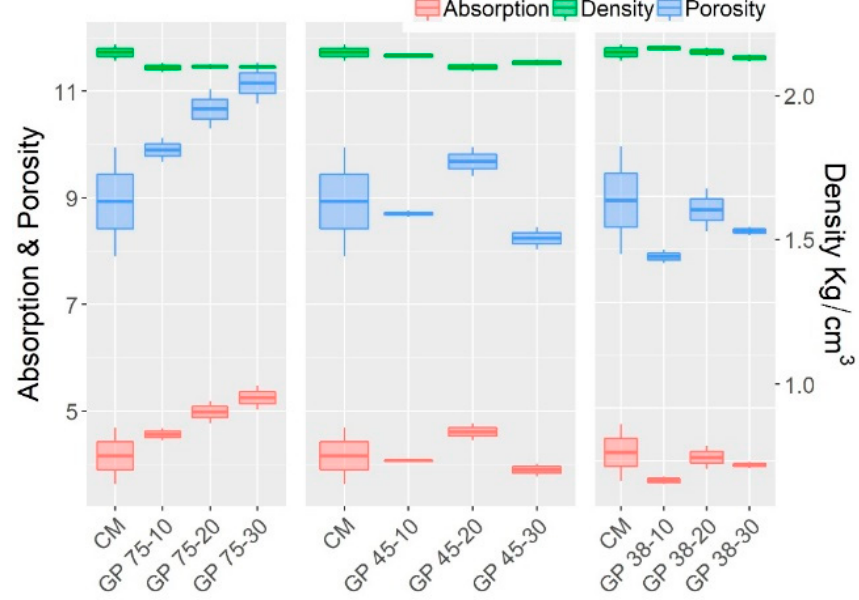
Figure 4. Absorption, porosity, and density results.